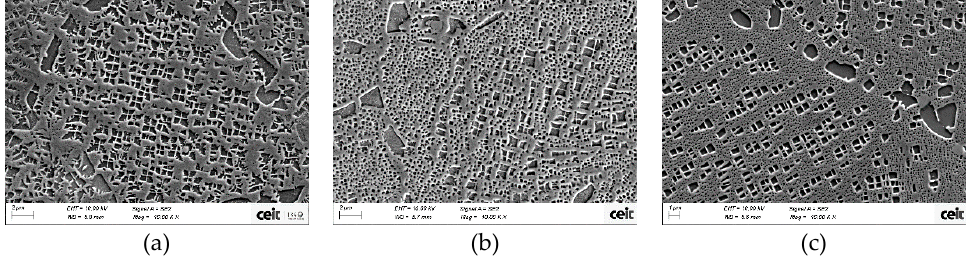
Figure 16. Astroloy microstructure revealed with kallings N°2 ( a ) after HIP and after HT-A for ( b ) can and ( c ) cube.